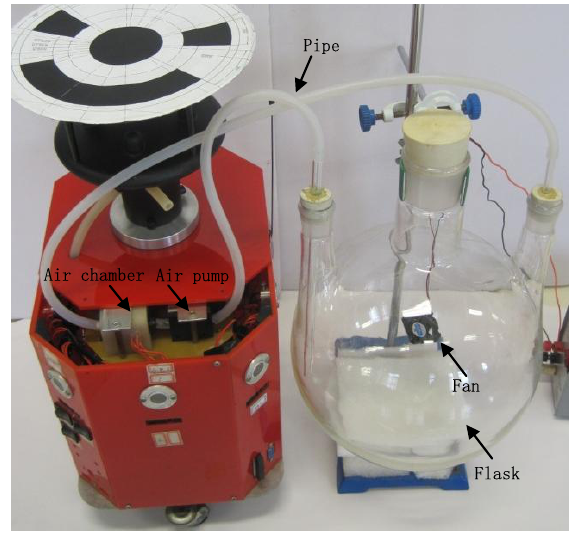
Figure 5. The device for gas sensor calibration. A TGS2620 gas sensor was mounted inside the air